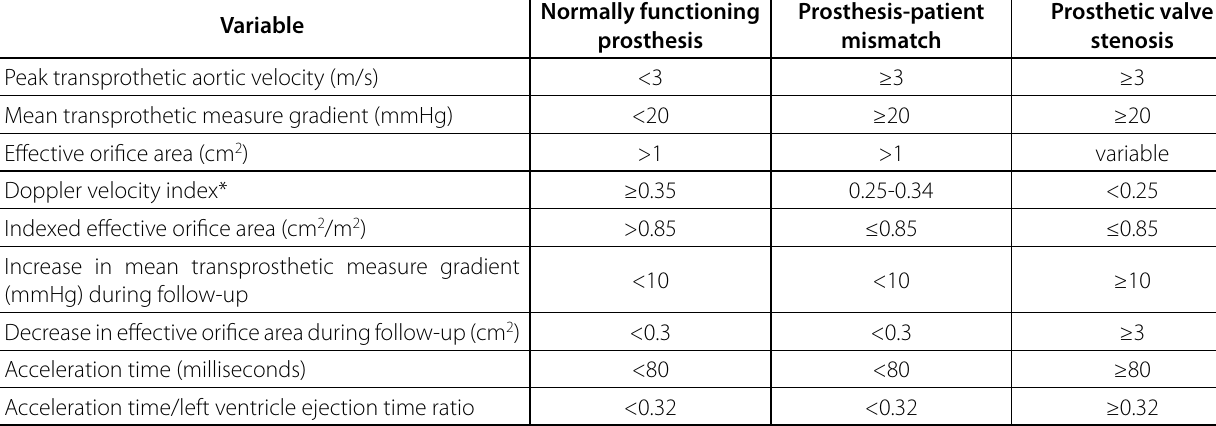
Table 1 . Imaging for differential diagnosis between normally functioning aortic prosthesis, prosthesis-patient mismatch and prosthetic stenosis (proposed by Pibarot et al. [6] ).